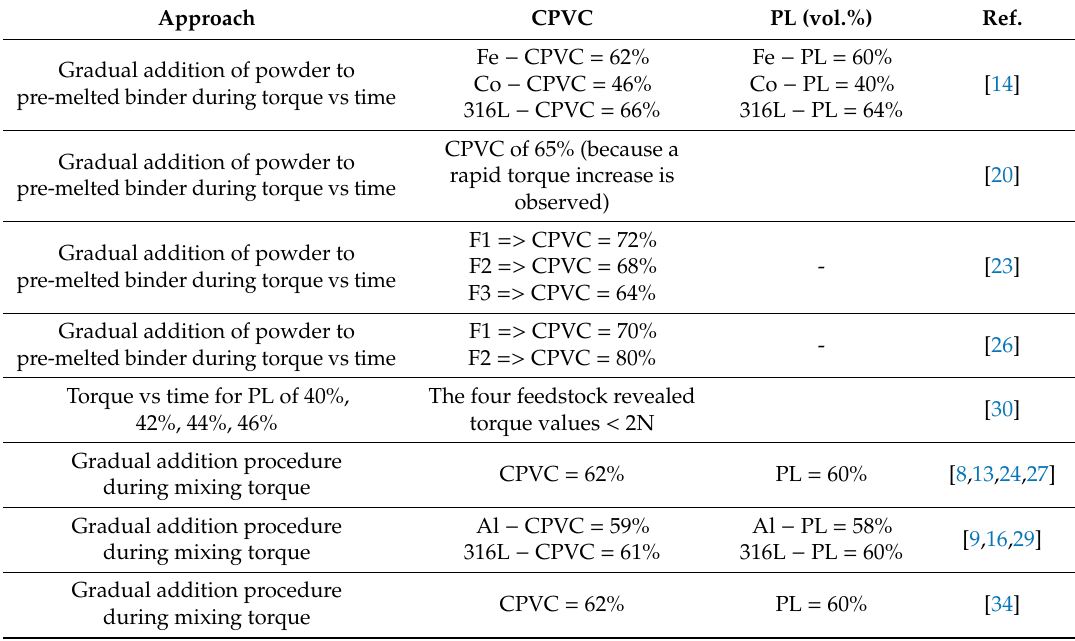
Table 3. Determination of critical powder volume concentration (CPVC) reported in some studies related with powder hot